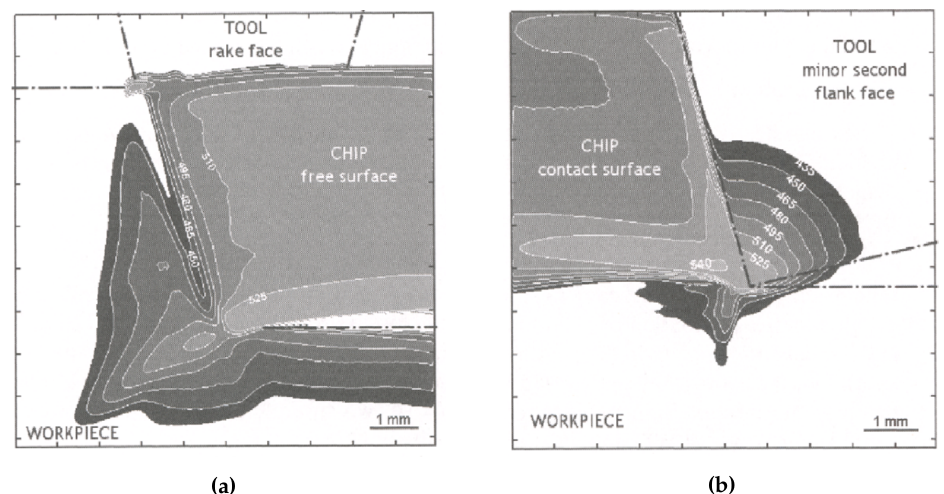
Figure 8. Temperature distribution in the chip during orthogonal cutting on AISI 1045 steel obtained with a camera in circumferential ( a ) and axial ( b ) directions